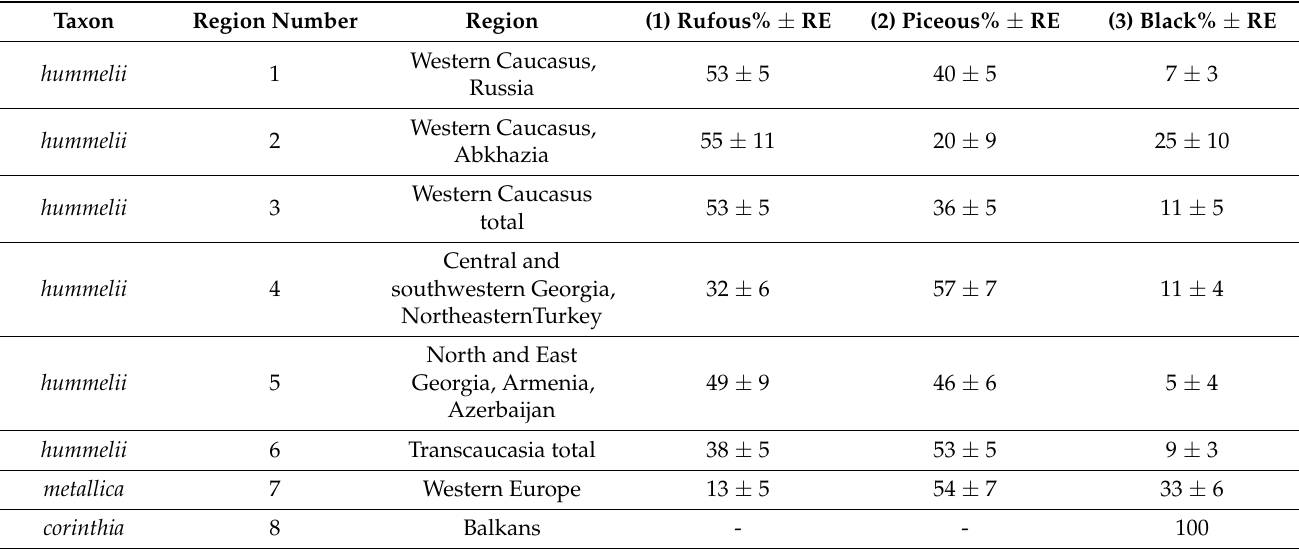
Table 10. Color of tarsi. RE—share representativeness error.